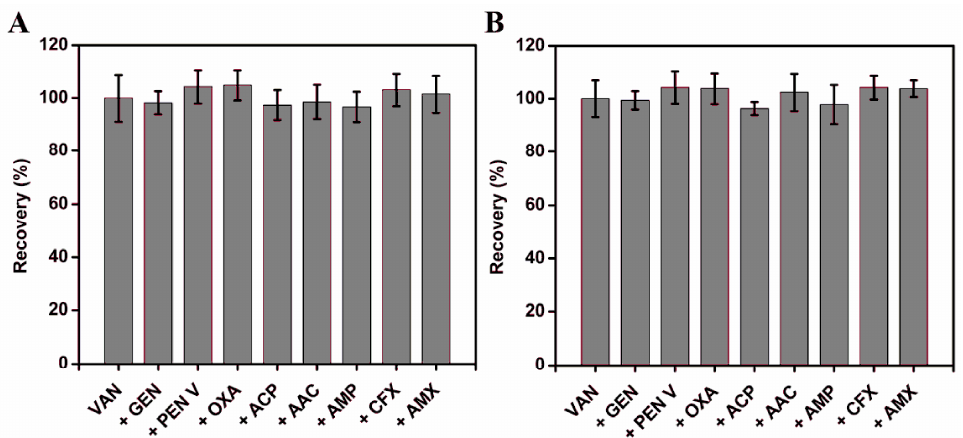
Figure 7. Selectivity tests using the optimized method for direct approach in oxidation ( A ) and for the indirect approach in reduction ( B ).